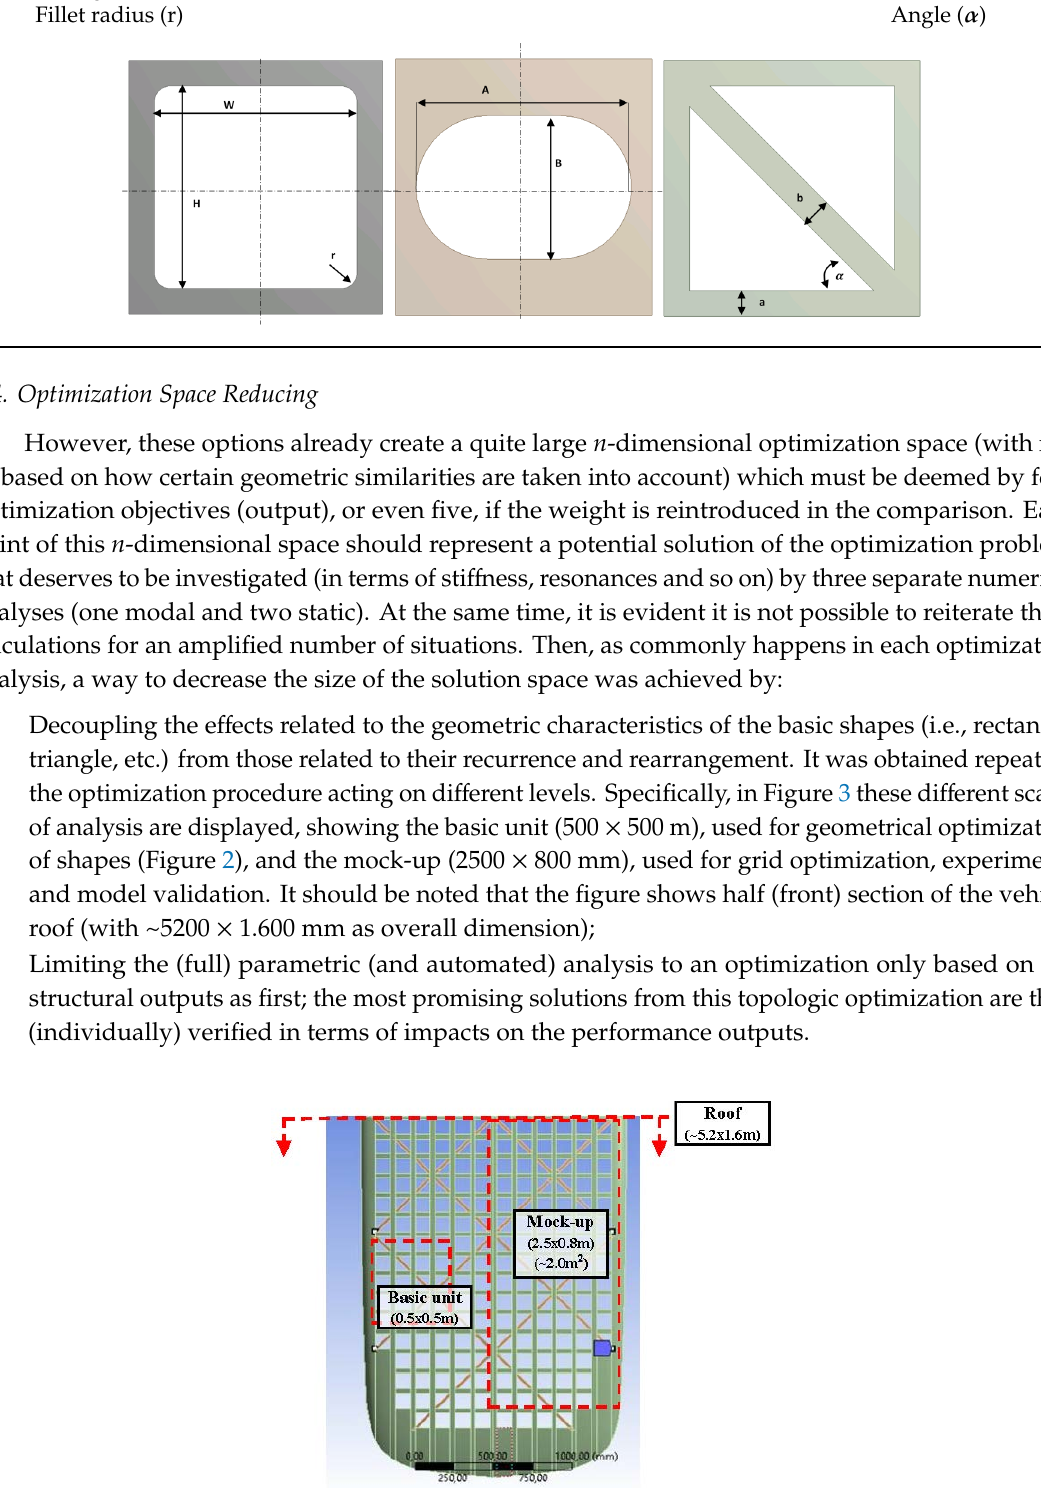
Figure 3. Different scales of analysis: basic unit (500 × 500 m), experimental mock-up (2500 × 800 mm) and half (front) section of the roof (~5200 × 1.600 mm).